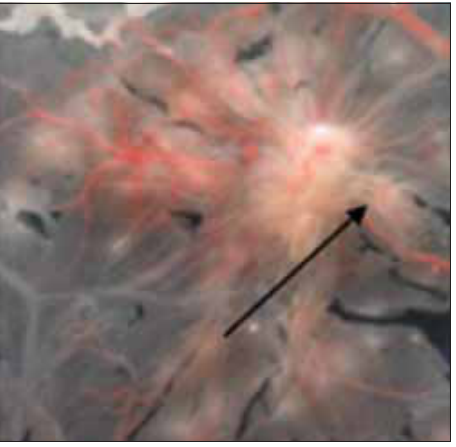
Figure-2: Pock produced by field strain of fowl pox virus (FPV) at third strain of FPV at third passage level.